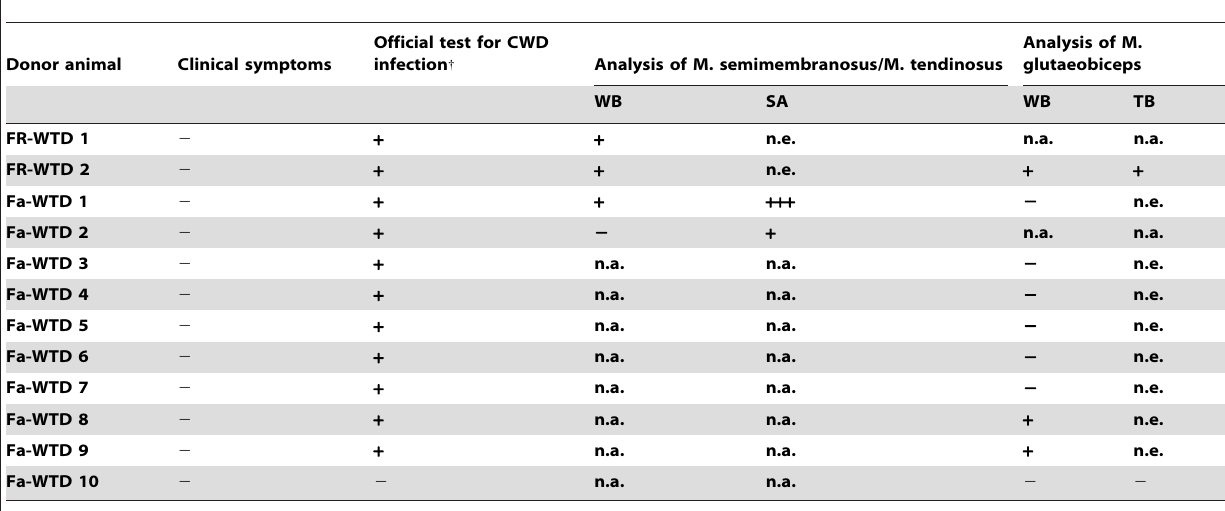
Footnote to Table 1. Explanation of abbreviations: n.a. – no tissue available for testing; n.e. – not examined; SA – PMCA testing for seeding activity of PrP TSE ; TB – Tissue blot testing for PrP TSE ; WB – Western blot testing for PrP TSE . Explanation of symbols: { Western blot testing of WTD brain tissue and/or lymph nodes for PrP TSE was performed by the responsible authorities in Canada or the USA in the context of CWD surveillance.